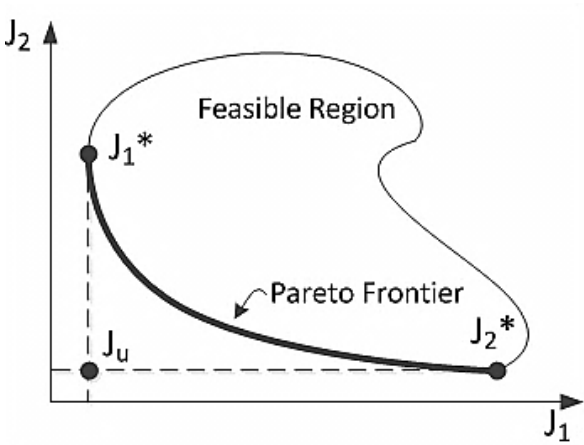
Fig. 1: Graphical representation of the design metric space of a